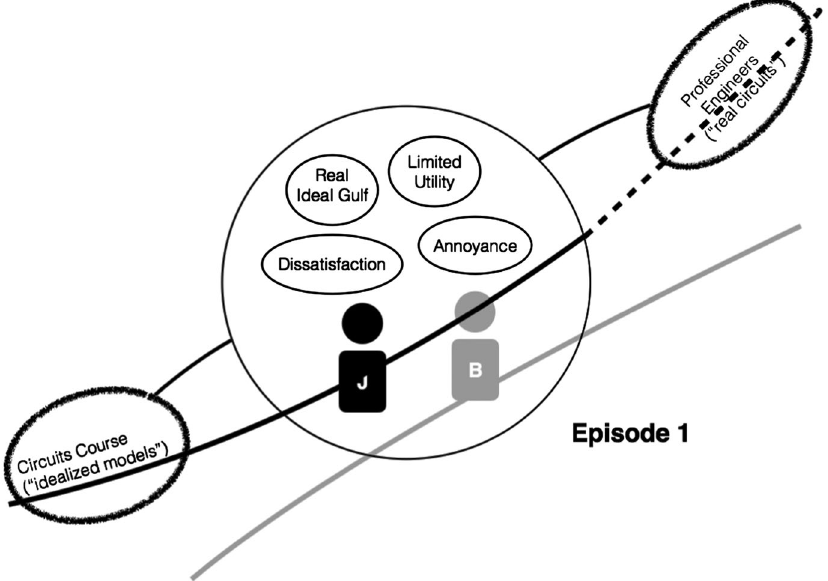
FIG. 2. Visual representation of the model for episode 1. Judy (marked as J) and Brian (marked as B) are shown as co-supporting the aspects of the interview conversation that we model labeled as real ideal gulf, limited utility, dissatisfaction, and annoyance. Judy ’ s trajectory through time (thick black line going through “ Judy ” ) is shown as moving through past experiences in the Basic Circuits course, through the present time of the interview, into the projected future (represented by dotted black line) of participating in community of professional engineers. It is highlighted (via thin connecting lines between the bubbles corresponding to the course, the interview, and projected professional engineering future) that in the interview, the course is positioned as having a focus on idealized models and professional engineers as being focused on real circuits. Real ideal gulf here refers to the epistemological stance of separation between real circuits and idealized models. Limited utility refers to the sense that idealized models are of limited utility to professional engineers in analyzing real circuits. Dissatisfaction refers to the sense of dissatisfaction at the circuits courses ’ emphasis on idealized models. And annoyance refers to the negative emotions Judy expresses when talking about idealized